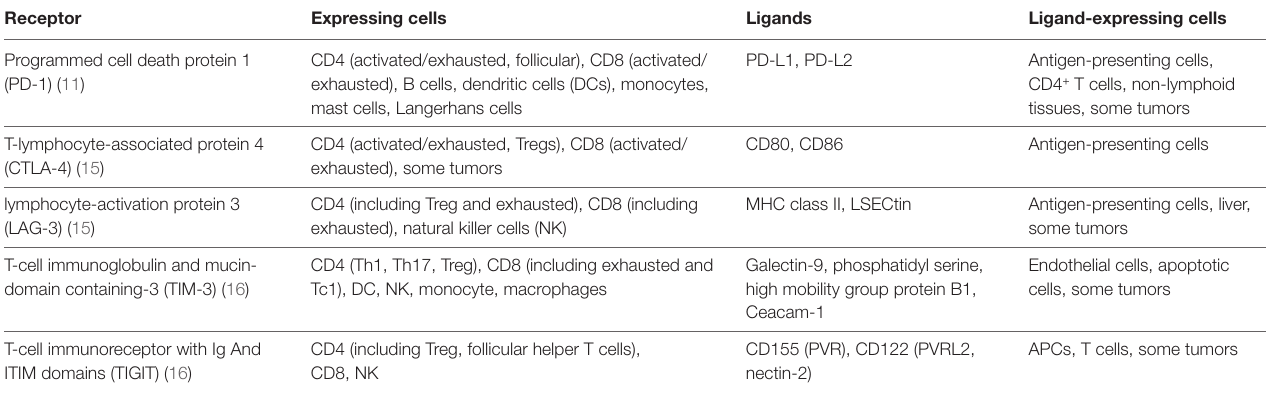
TAbLe 1 | Overview of T cell surface receptors associated with immune inhibition and dysfunction . Receptor expressing cells Ligands Ligand-expressing